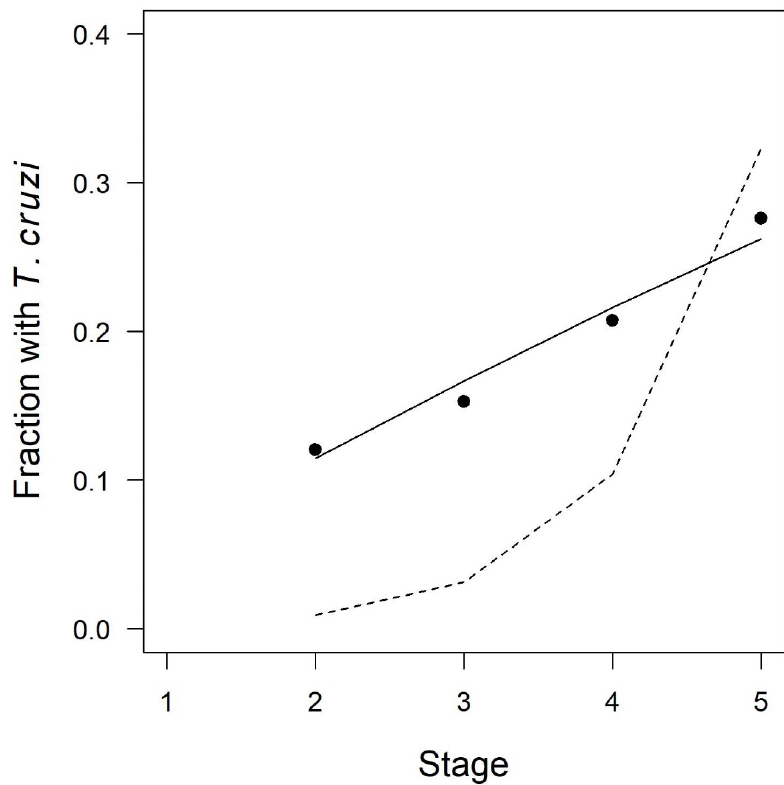
Figure 4. Fraction of triatomines infected with Trypanosoma cruzi as a function of stage. Filled circles: mean values observed in 15,252 insects captured at 188 infected sites. Dashed line: Best-fit regression model under the Blood Hypothesis that assumed an equal probability of infection with each milligram of blood ingested ( Pr(infection ) = 1 − (1 − 0.00036)ˆ Nblood, where Nblood is the number of mg of blood ingested). Solid line: Best-fit regression model under the Bites Hypothesis that assumed an equal probability of infection during any given stage ( Pr(infection ) = 1 – (1 − 0.059)^ N ). Table 2. Results of regression modeling to test two hypotheses of T. cruzi transmission to T. infestans .